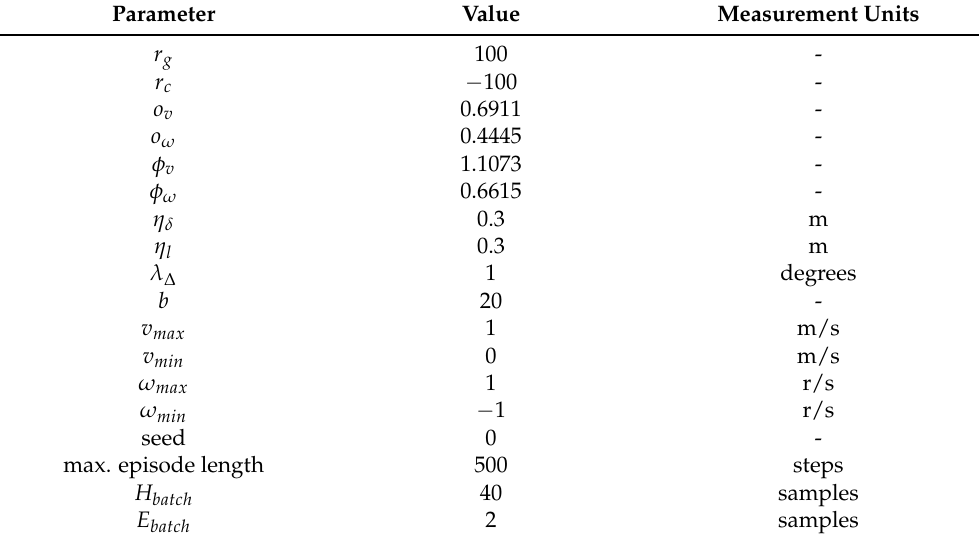
Table 3. Training parameter